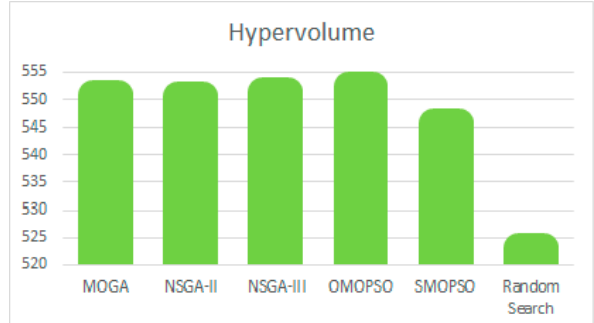
Figure 12. Average hypervolume of each algorithm.